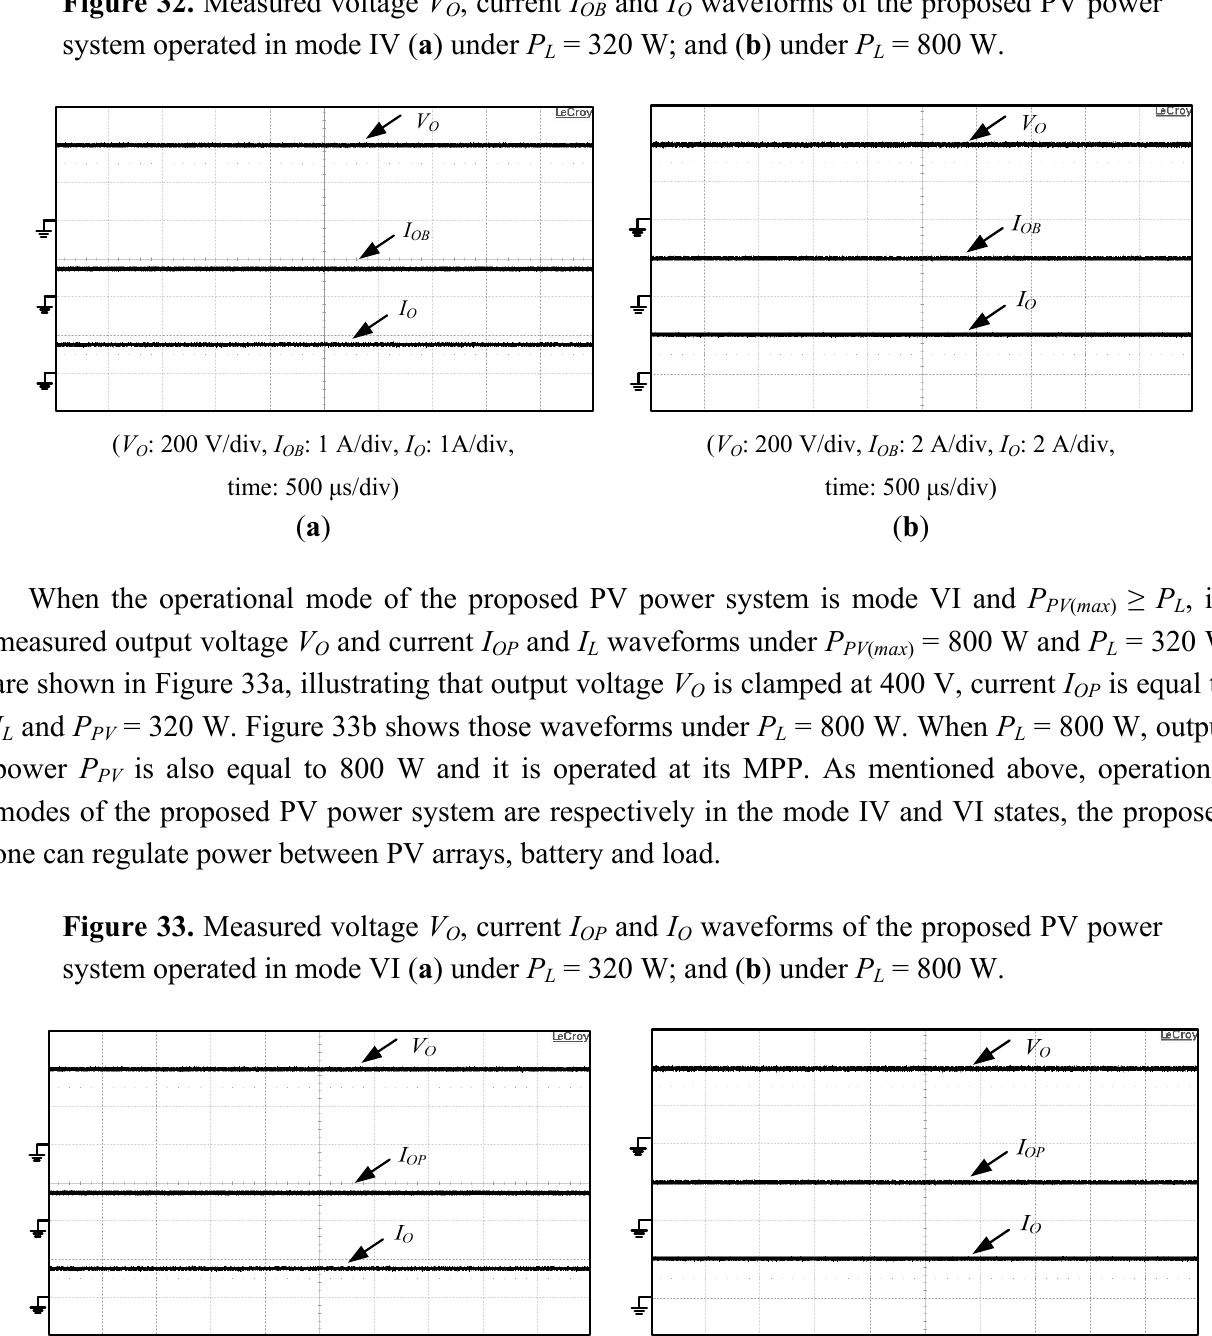
Figure 32. Measured voltage V system operated in mode IV ( a ) under P